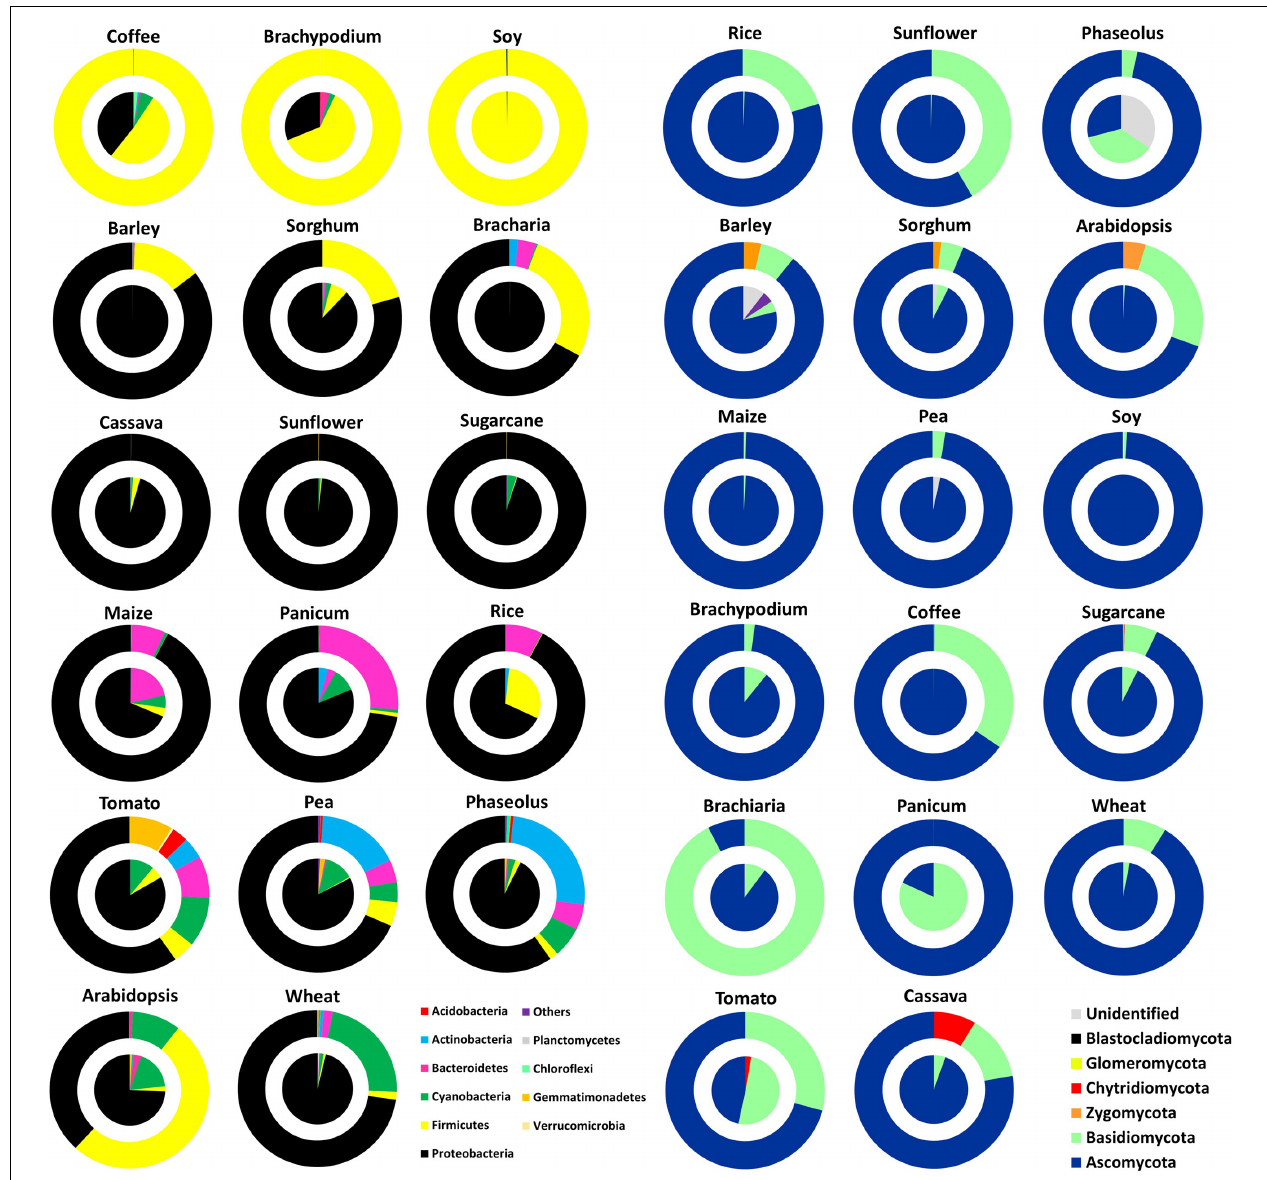
FIGURE 2 | Phylum level classification of bacterial 16S rDNA (A) and fungal ITS DNA (B) amplified from seeds (pies) and spermospheres (donuts) of the 17 different plant species used in this study. OTUs in each repetition were grouped by sample type and color classified by phylum to yield relative proportion by sample. Seeds and spermospheres were added together and sorted by agglomerative hierarchical clustering using Bray–Curtis dissimilarity of phylum